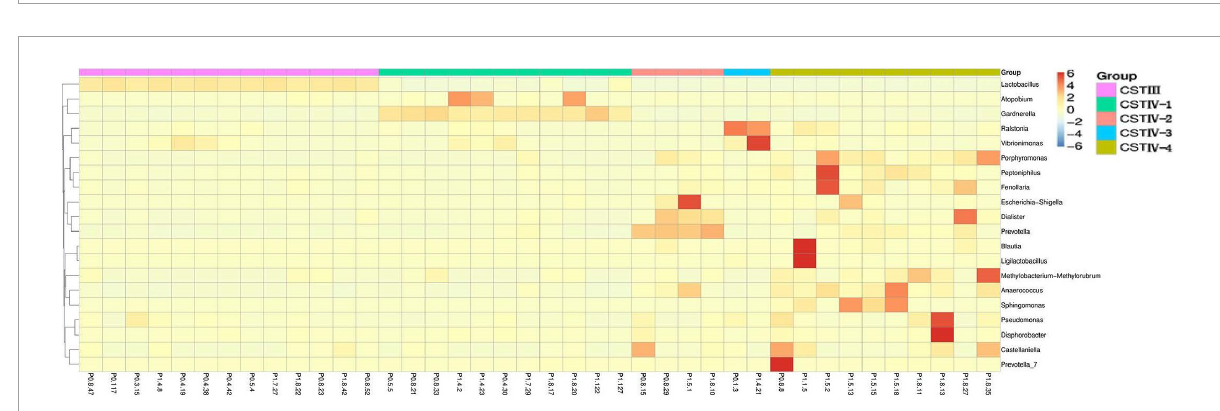
FIGURE2 Heat map of the vaginal microbiota with representative 40 participants at genus level. The color key indicates taxon abundance; the order is based on the community state types